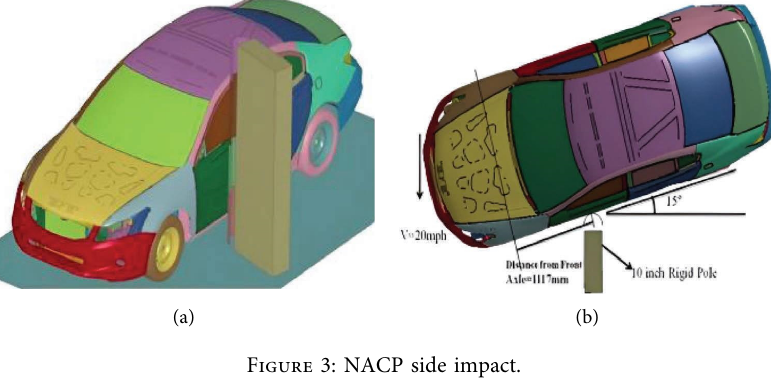
Figure 3: NACP side impact.